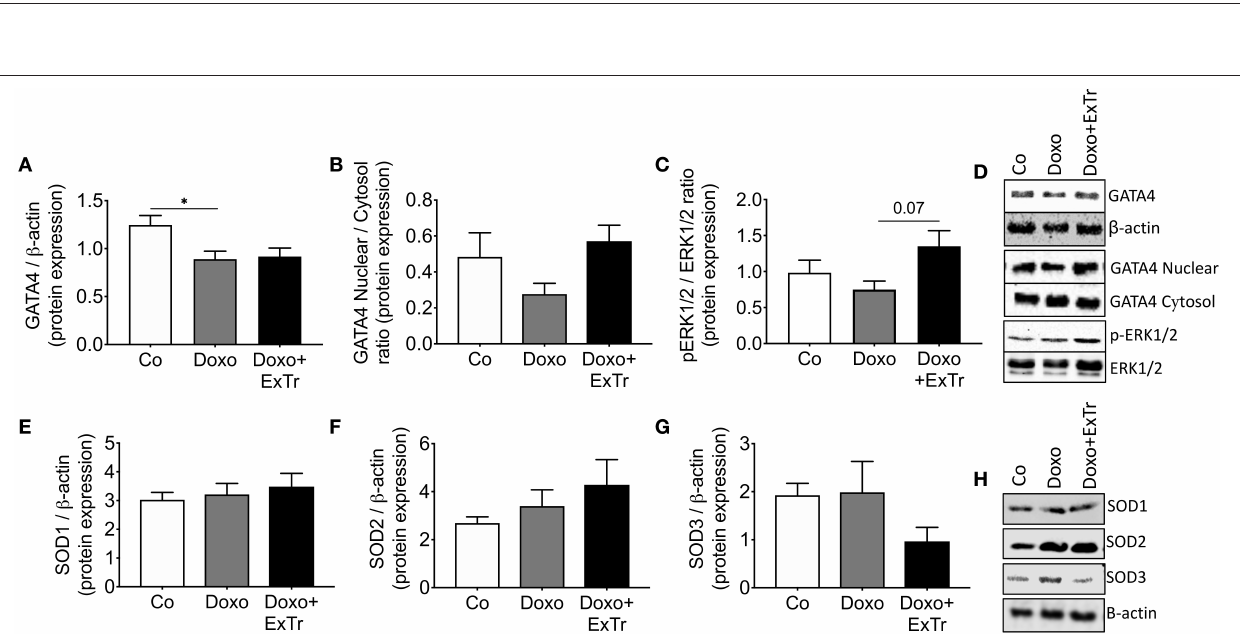
Frontiers in Cardiovascular Medicine |